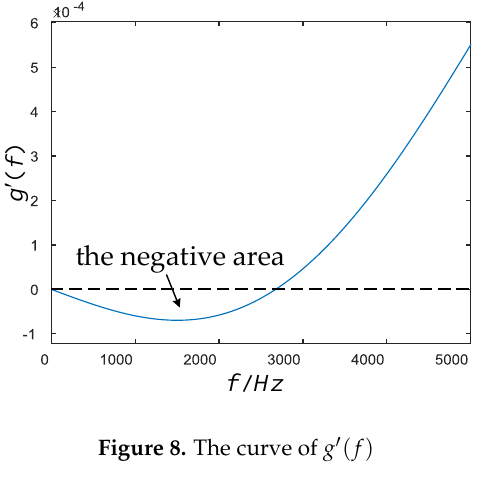
Figure 8. The curve of ( ) g f .